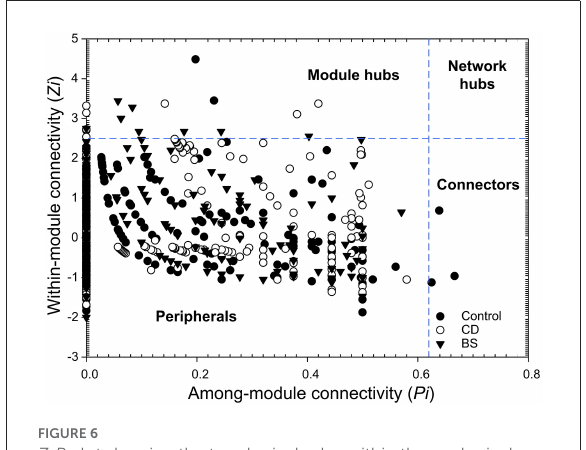
FIGURE6 Z-P plot showing the topological roles within the ecological